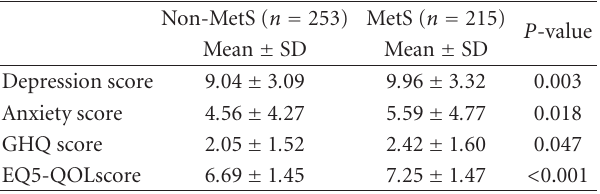
Table 2: Psychological variable according to the presence or absence of metabolic syndrome.